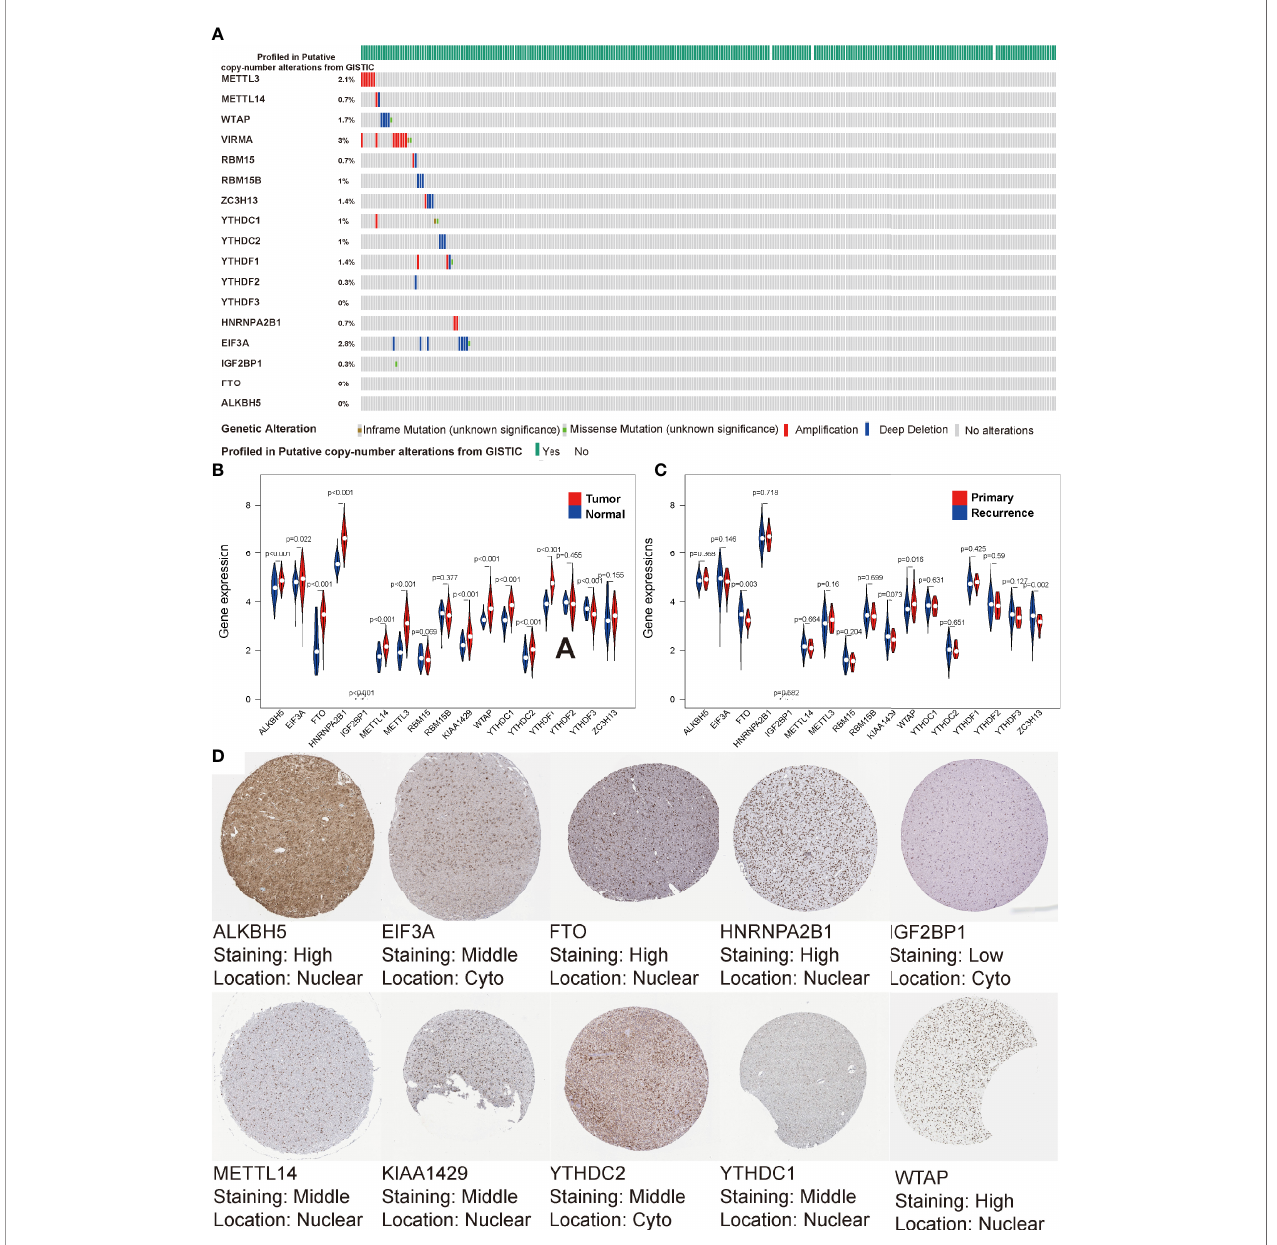
FIGURE 1 | Transcriptome and proteome levels of m6A regulators and clinical parameters in low-grade gliomas (LGG). (A) Genetic alteration pro fi les of the studied m6A modi fi cation regulators from 529 patients with LGG. (B, C) Violin diagrams of expression levels of the m6A regulators (normal sample vs tumor sample) (B) and (primary LGG vs recurrent LGG) (C) from TCGA database. (D) Immunohistochemistry staining of m6A RNA regulators in LGG retrieved from Human Protein